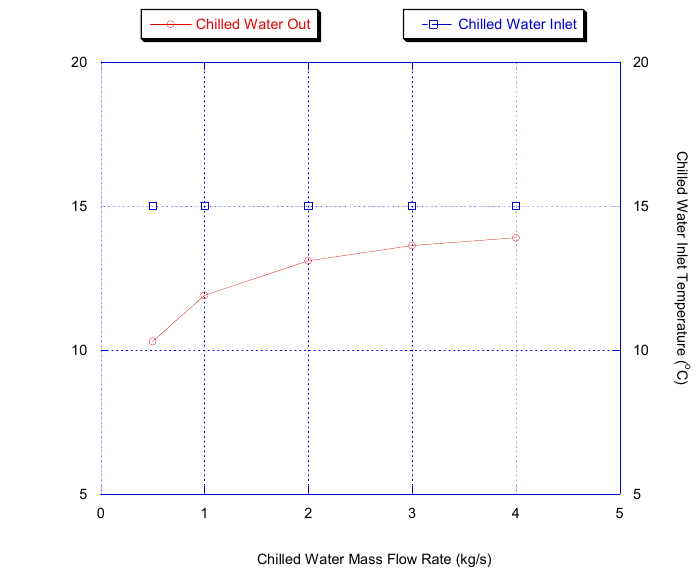
Figure 6. Effect of chiller flow rate on chiller outlet temperature (results are at chiller nominal operating conditions, shown in Appendix B).